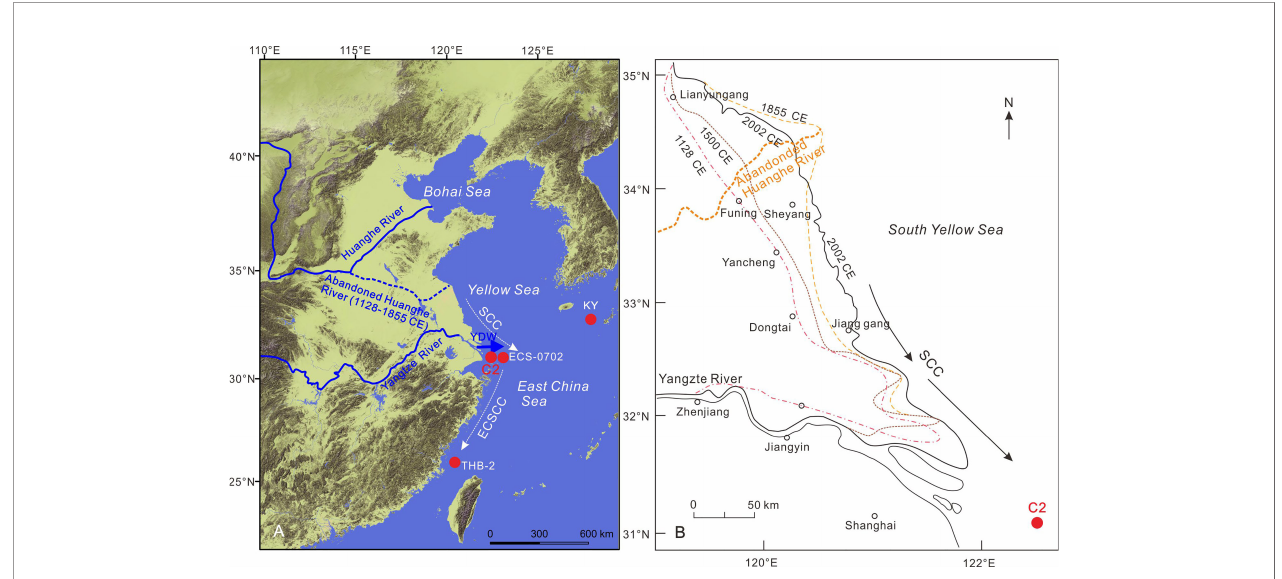
FIGURE 1 | (A) Map of the study area; (B) variations in the YRD and AHD coastlines over the past 1000 years (modi fi ed from Zhang, 1984; Liu et al., 2010) and the location of the Core C2 site. The SCC line denotes the Subei Coastal Current, and the ECSCC line is the East China Sea Coastal Current; YDW,q Yangtze River Diluted